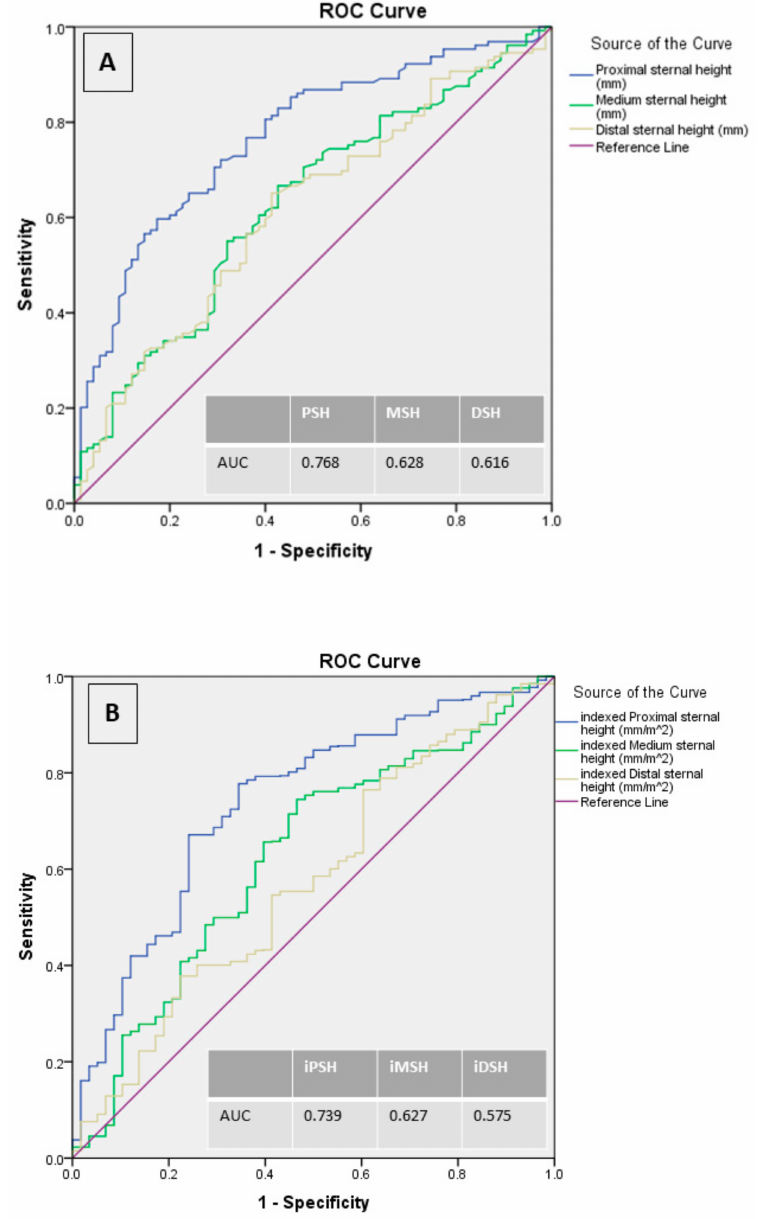
Figure 2. Receiver operating characteristics (ROC) curve models and the corresponding area under the curve (AUC) for sternal measurements in relation to sternal dehiscence (panel A ) and indexed sternal measurements in relation to more than Grade 1 Surgical Site Infection (panel B